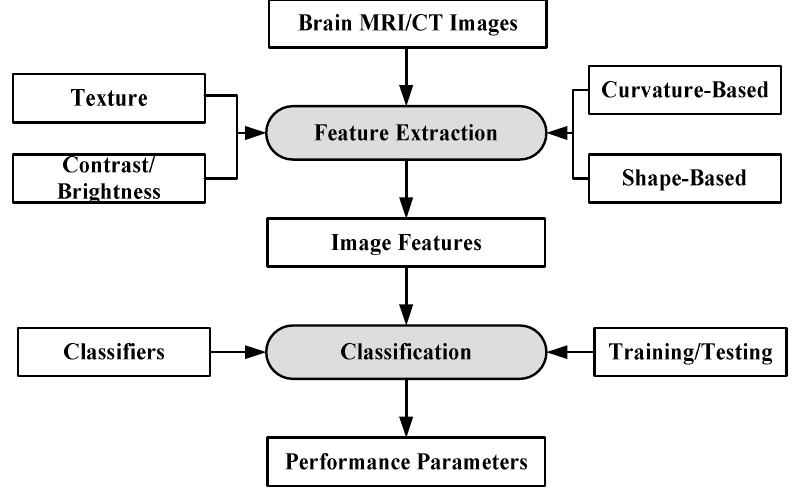
Figure 3. Working of ML‐based algorithms.